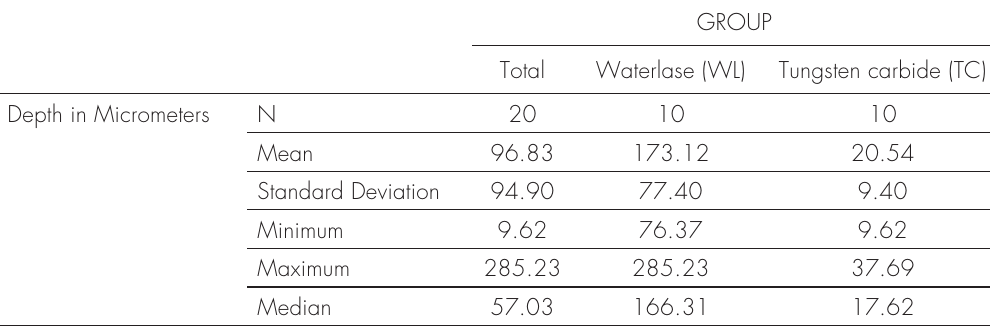
Table II. Statistical description of removal